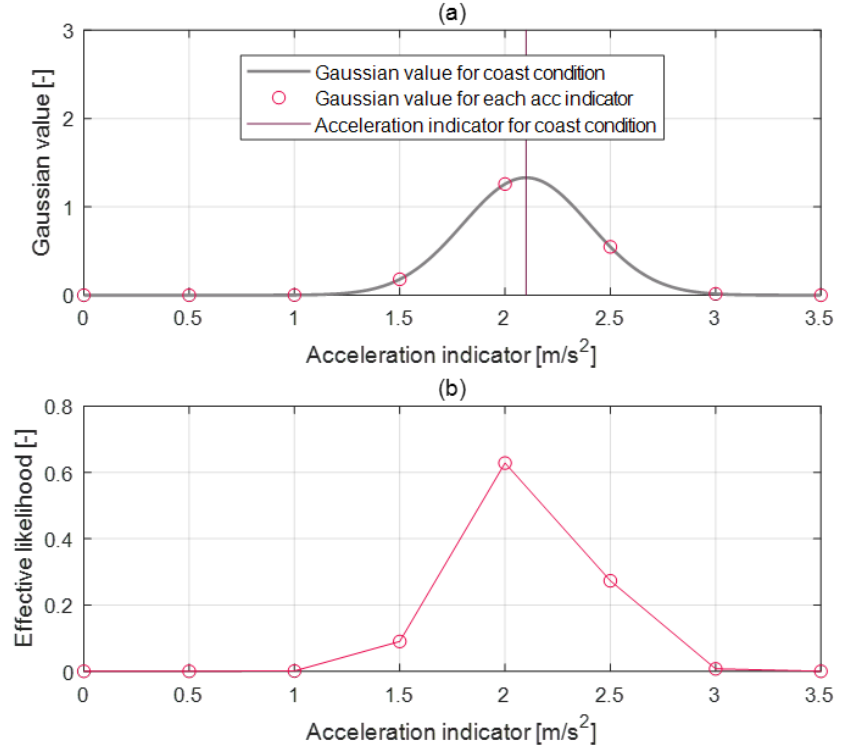
Figure 14. Gaussian value and effective likelihood according to acceleration indicator value. ( a : Gaussian value, b : Effective